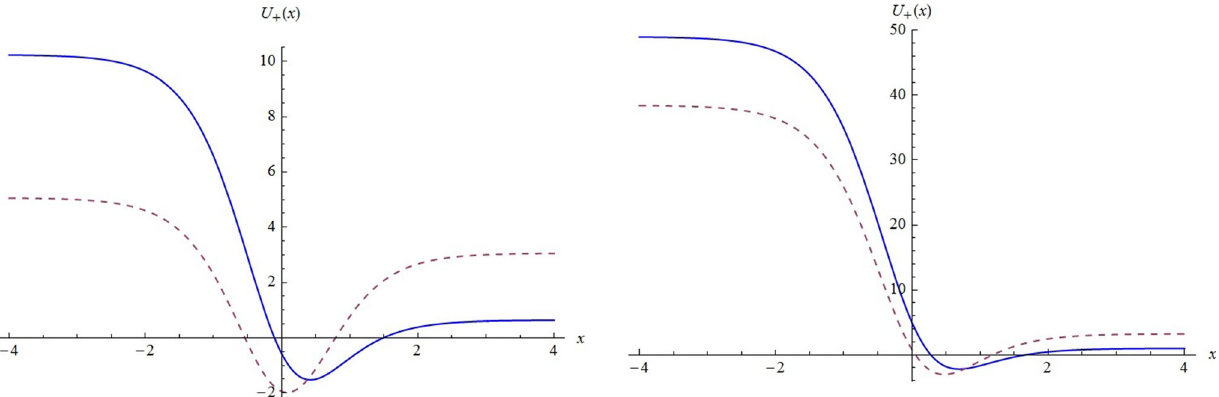
Fig. 3 Quantum mechanical potential U + ( x ) associated to the ) model for different values of the parameters. On extended (φ 4 + ϕ 6 l the left, we have plotted the potential with c = − 1, and b = 0 . 6 (solid